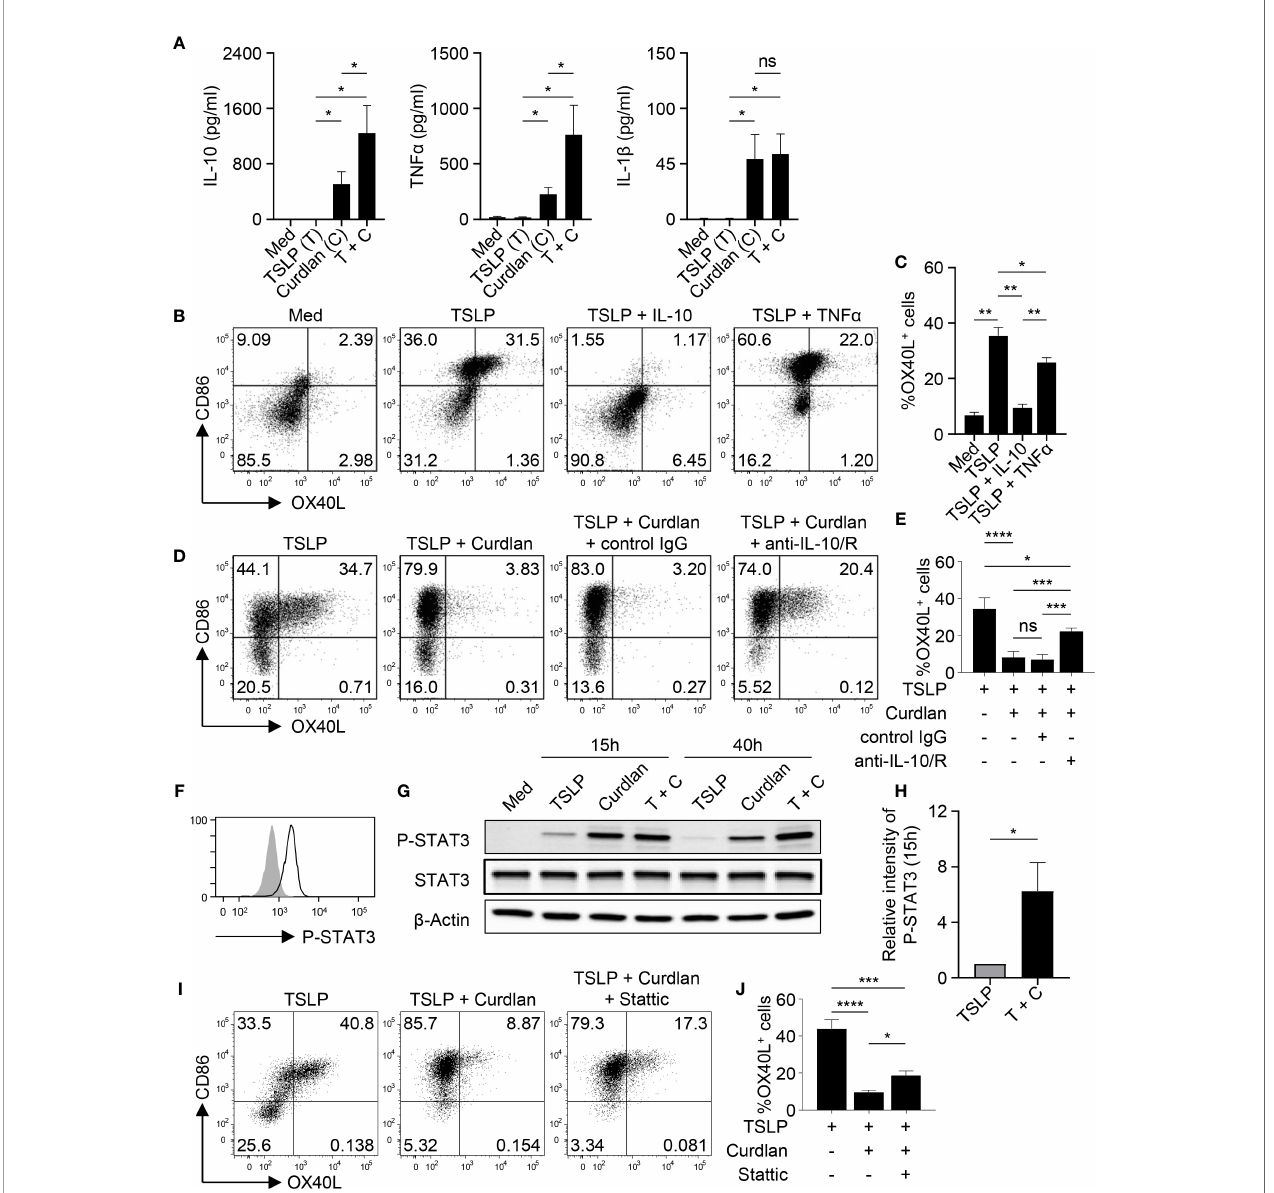
FIGURE 3 | IL-10 Downregulates TSLP-Induced OX40L in an Autocrine Manner. (A) Cytokine expression by mDCs (n = 4) upon indicated stimulation was analyzed by multiplex assay. (B, C) Sorted mDCs were treated indicated reagents for 48h before surface staining of CD86 and OX40L. Representative FACS data (B) and summarized data (C) from different donors (n = 4) are shown. (D, E) Sorted mDCs were pre-incubated with anti-IL-10 and anti-IL-10R, or isotype control before stimulation with TSLP and/or curdlan for 48h followed by surface staining of CD86 and OX40L. Representative FACS data (D) and summarized data (E) from different donors (n = 4) are shown. (F) STAT3 phosphorylation (open histogram) was detected in mDCs treated with TSLP and curdlan for 48h. Tinted histogram denotes isotype control. Representative FACS data of three independent experiments is shown. (G, H) Treatment with TSLP plus curdlan, when compared with TSLP alone, enhanced STAT3 phosphorylation in mDCs. Representative immunoblot (G) and summarized data (H) of different donors (n = 3) upon treatment for indicated time are shown. The intensity of P-STAT3 was fi rst normalized to that of b -Actin in the same group, and then relative intensity was obtained by comparison with Med group. (I, J) Sorted mDCs were pre-incubated with STAT3 inhibitor Stattic for 3h before stimulation with TSLP and/or curdlan for 48h followed by surface staining of CD86 and OX40L. Representative FACS data (I) and summarized data (H) from different donors (n = 3) are shown. Data in (A, C, E, H, J) are represented as mean ± SD. Signi fi cance was determined using one-way ANOVA with Tukey multiple comparisons test for (A, C, E, J) and paired t test (two-tailed) for (H) . * p < 0.05, ** p < 0.01, *** p < 0.001, **** p < 0.0001 for the comparison between groups. ns, not signi fi